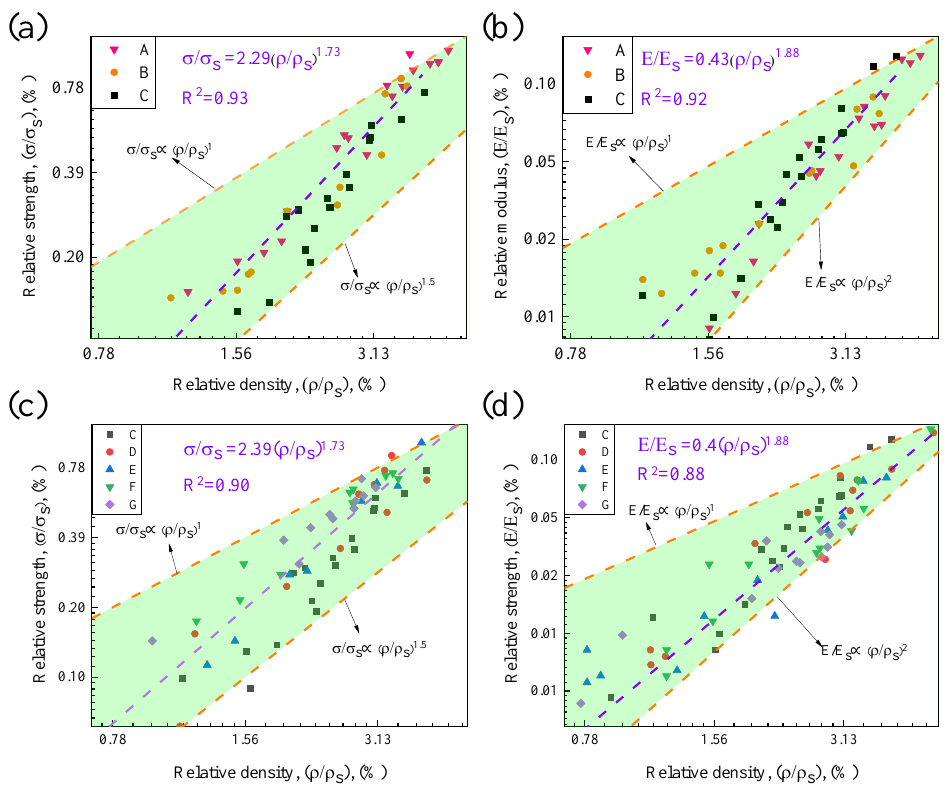
Figure 8. Mechanical properties of lattices with different length-diameter ratios: ( a , c ) strength; ( b , d ) modulus.